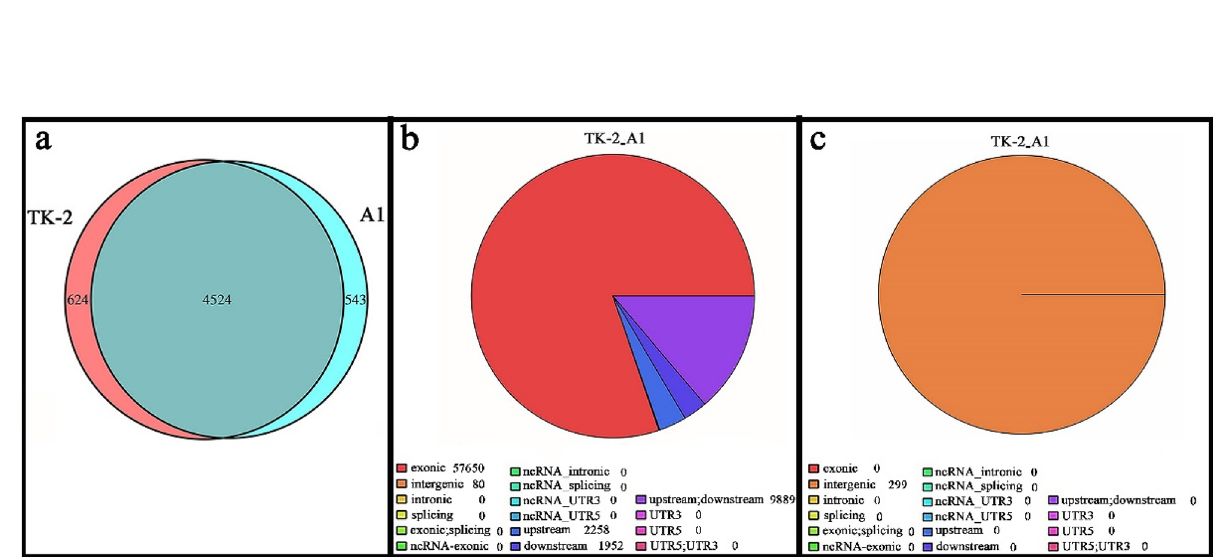
Figure 6. ( a ) Venn diagram of common and unique genes analysis. ( b , c ) Detection and annotation of SNPindel and